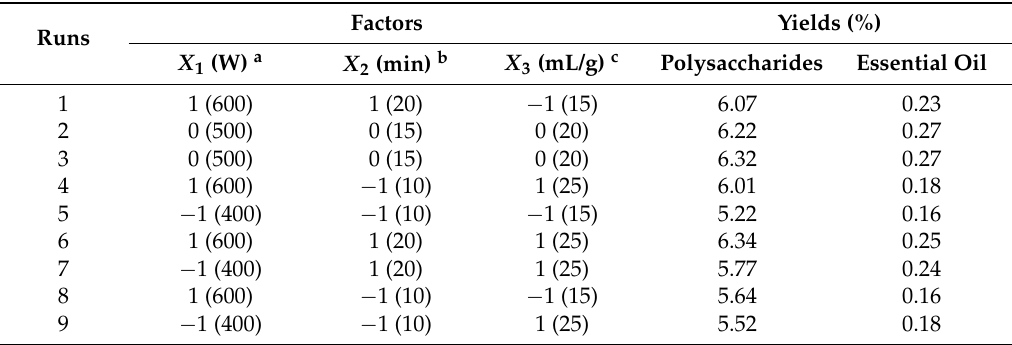
Table 1. Experimental conditions used for the central composite design analysis and the corresponding measured